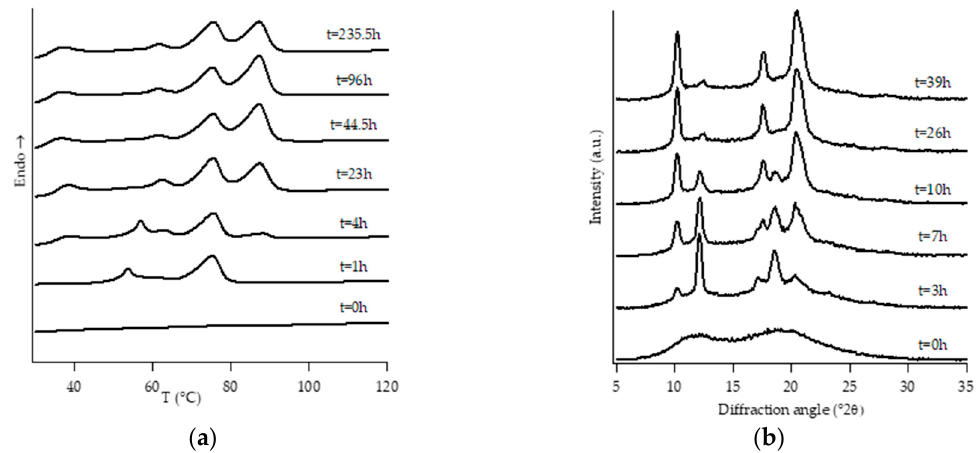
Figure 3. DTA thermograms ( a ) and WAXD patterns ( b ) of PB2.4 at different aging times.